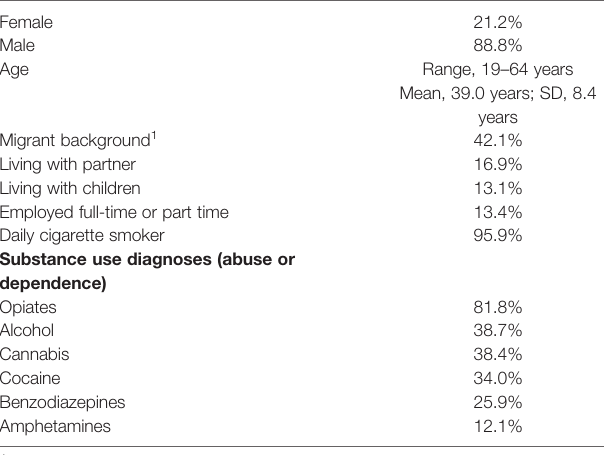
TABLE 1 | Sociodemographic characteristics and substance use diagnoses of the study sample (n =